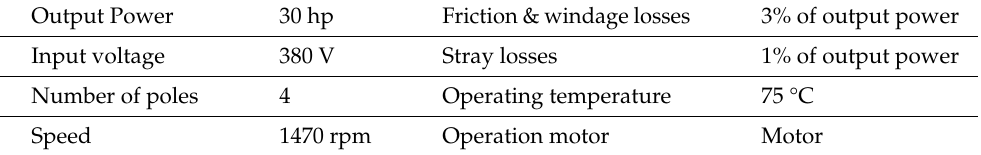
Table 2. General Design Data.